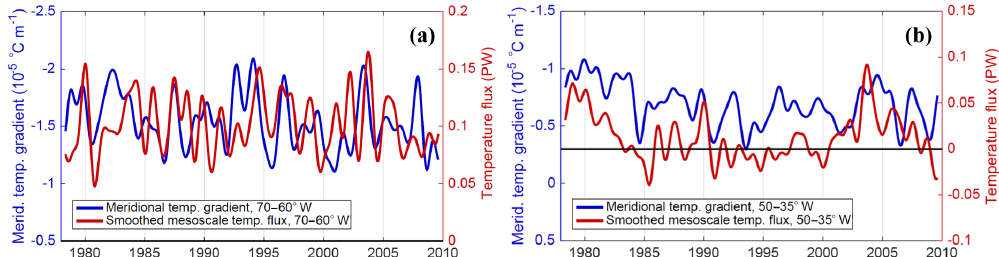
Figure 14. (a) Time series comparison of 0–1000m meridional temperature gradient averaged along the 40 ◦ N transect between 70 and 60 ◦ W (boundary region), with the zonally smoothed mesoscale temperature flux integrated in the same region. The y axis of the meridional temperature gradient is inverted to align its orientation with the MTF. Panel (b) is the same as (a) but in the interior region (50–35 ◦